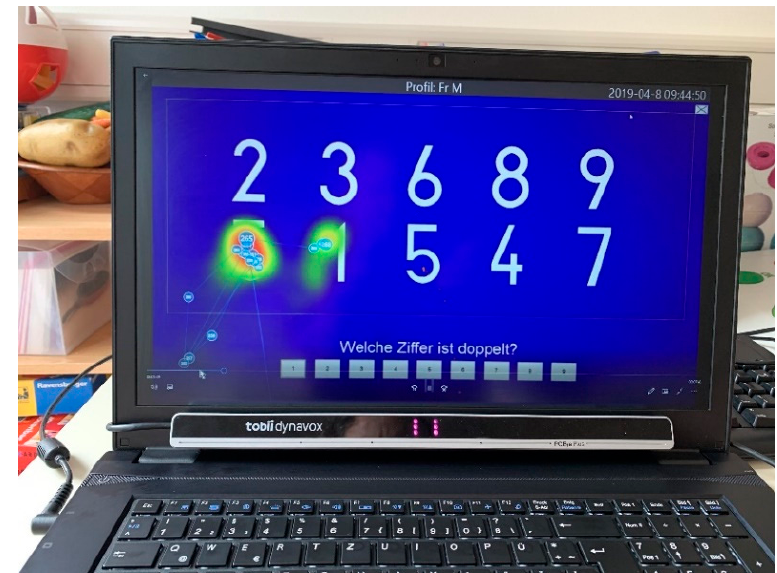
Figure 7. The bar between the keyboard and the screen is an eye tracking device, which helps the therapist understand where the patient is looking. In this case the patient is being encouraged to look at all the numbers including the ones to the right, neglected side of the screen, although in the image the patient’s eyes are drawn to the bottom left two numbers.